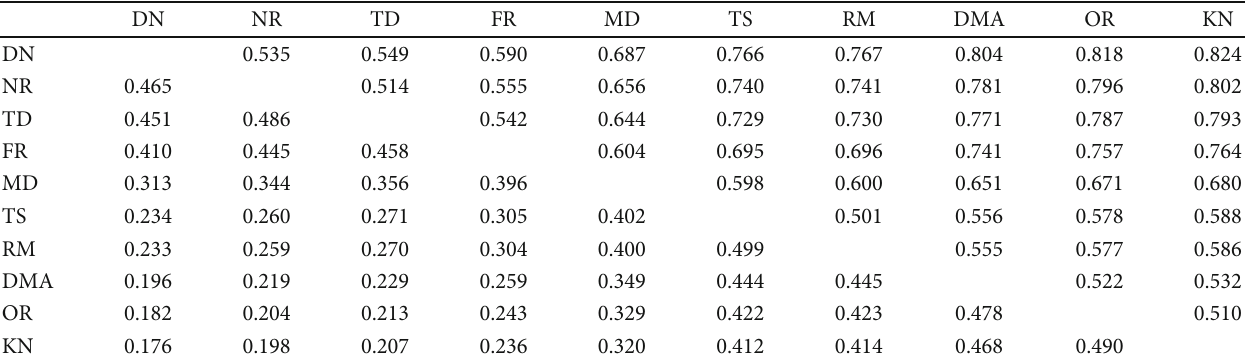
Djokovic N. Tsitsipas S. Rublev A. Wawrinka S. Opelka R.Isner J. Figure 5: Estimated relative abilities of tennis players on hard court only. Table 4: Wining probabilities of players on hard court. DN: Djokovic N.; NR: Nadal R.; TD: Thiem D.; FR: Federer R.; MD: Medvedev